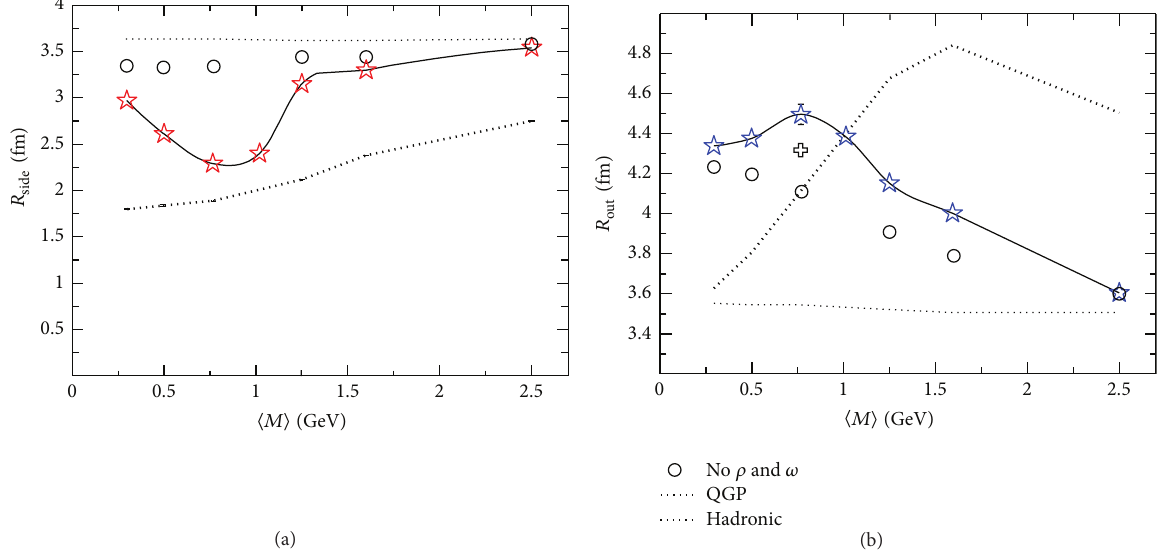
Figure 31: (a) 𝑅 is evaluated with 𝑝 1𝑇 = 𝑝 2𝑇 = 2 GeV and 𝜓 2 = 0 as a function of ⟨𝑀⟩ for RHIC energy and (b) 𝑅 side = 𝜓 = 0 and 𝑝 = 2 as a function of ⟨𝑀⟩ for RHIC [14, 15]. 𝜓 1 2 1𝑇